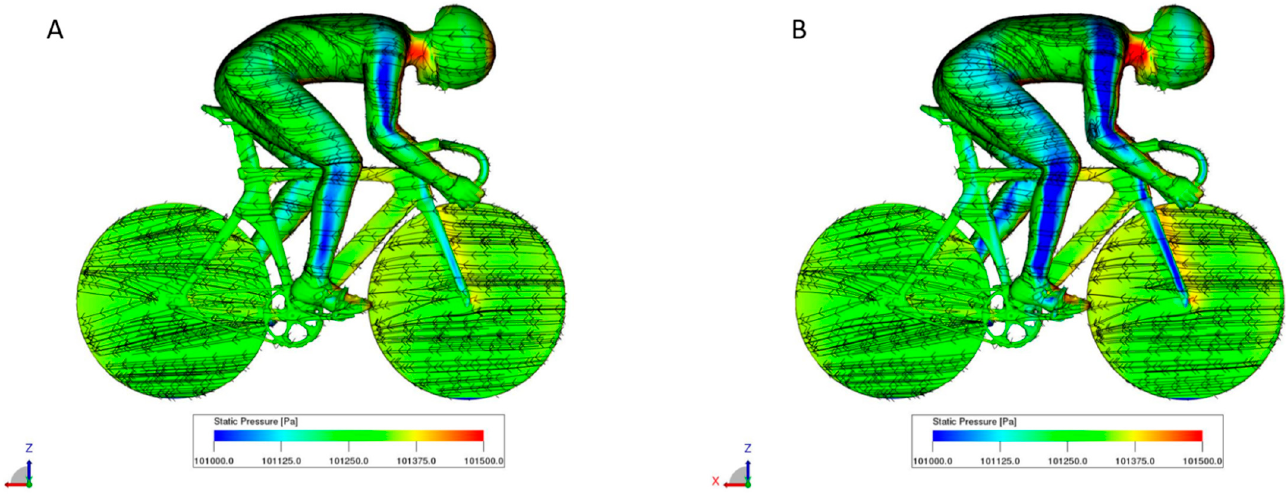
Figure 6. Side views of the time-averaged surface pressure distribution (contour and flow lines), ( A ) represents the model at 16 m/s and ( B ) at 20 m/s.